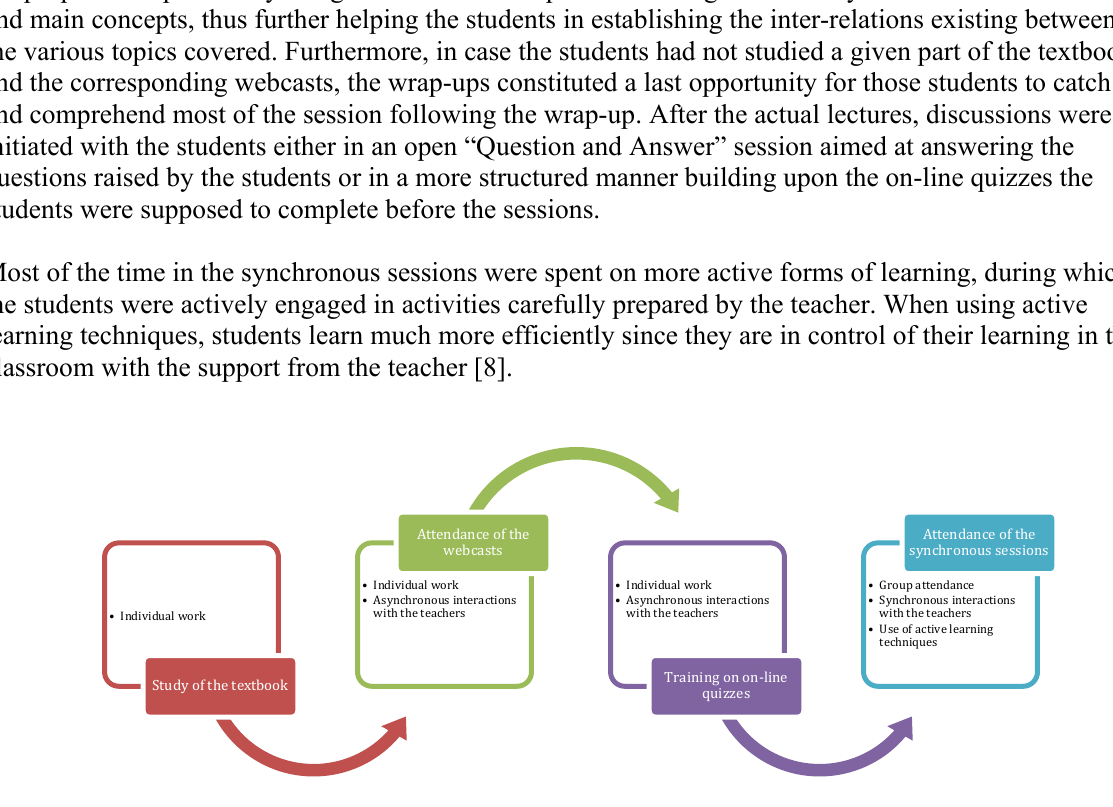
Fig. 3 – Summary of the pedagogical